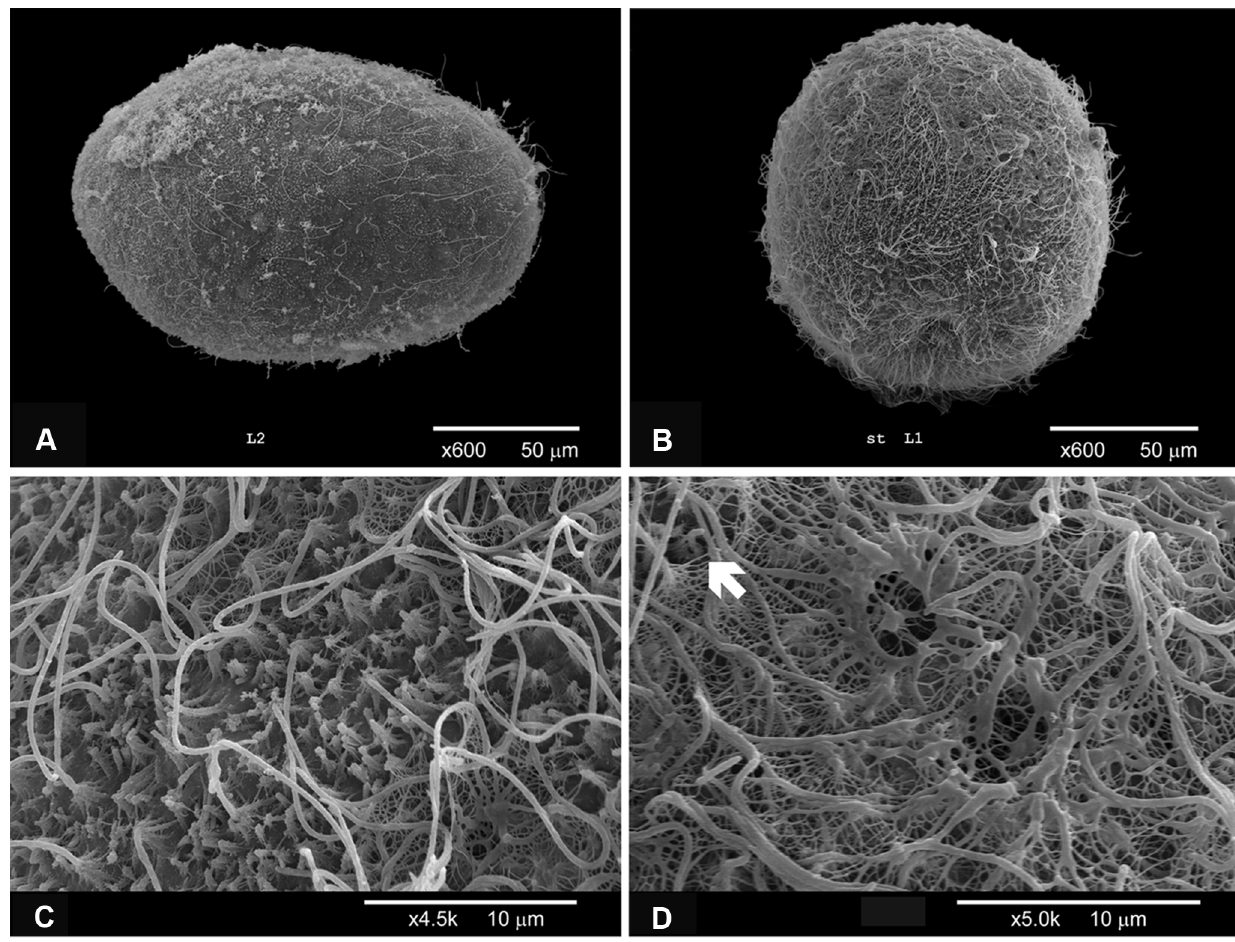
Figure 4. Scanning Electron Micrographs of Lopheliapertusa embryos and larvae. Image ( A ) shows a 6 days old ciliated embryo where each cell bears a cilium for locomotion. No oral pore or specialized structures are visible on the embryos at this stage; ( B ) A 4.5 weeks (31 days) old planula. The larva is fully and densely ciliated, and specialized structures are now visible. Larger pores are scattered over the surface, i.e. openings of mucus cells, and the oral pore facing downwards; ( C–D ) Close-ups of the body surface of 4.5 weeks old larvae; ( C ) ciliated ectoderm with mucus visible as web-like structures around the mucus cell openings; ( D ) mucus cell openings with webs of mucus. The white arrow marks out what appears to be a cnidocil, the trigger of a cnidocyst (a small bent cilium).